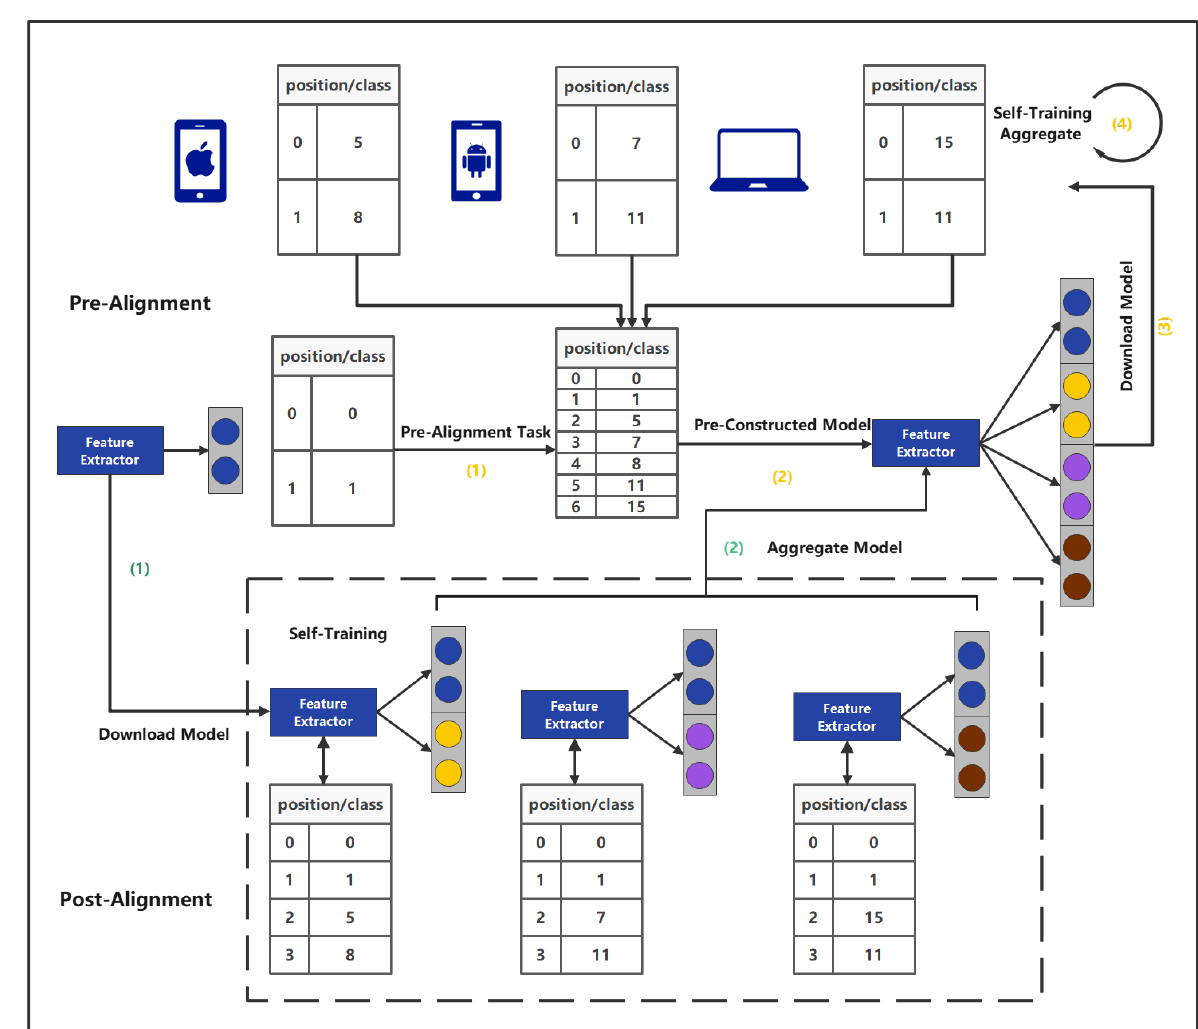
Figure 5. Pre-alignment and post-alignment workflow Pre-Alignment